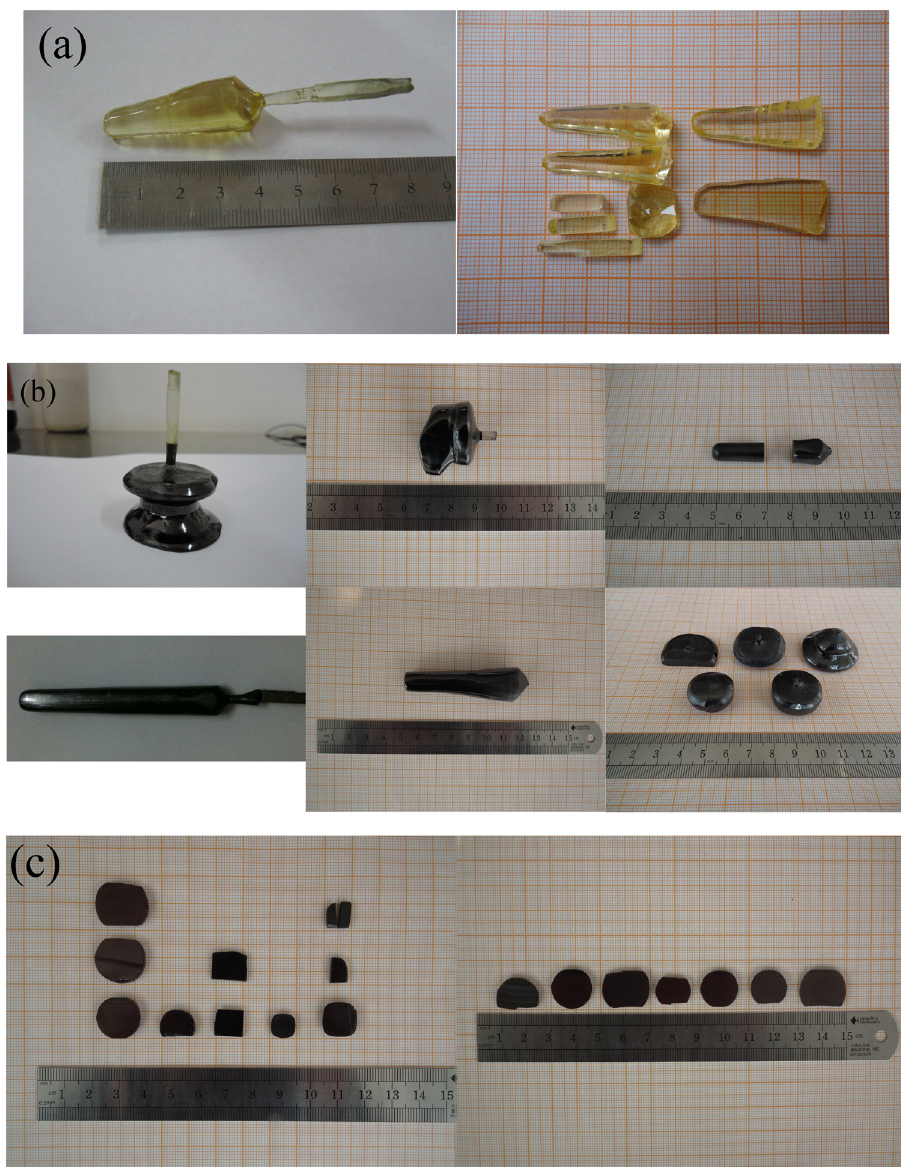
Figure 1: Photographs of as - grown YVO 4 and Ce 3 + - doped YVO 4 single crystal. ( a ) Pure YVO 4 single crystals, ( b ) Ce 3 + - doped YVO 4 single crystals with di ff erent doping concentrations, ( c ) Ce 3 + - doped YVO 4 single - crystal slices ( the Ce 3 + doping concentrations vary from x = 0.005 to x = 0.06. The thickness of these slices is 2.00 mm after optical polishing )